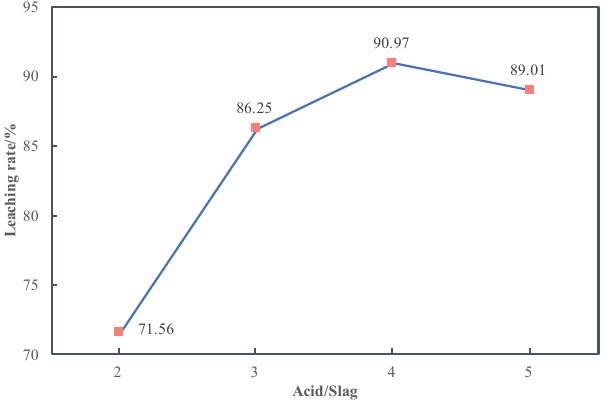
Figure 3. Effect of acid/slag ratios on leaching rate of titanium.